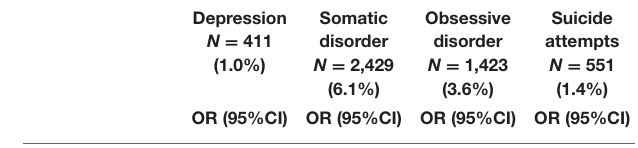
TABLE 2 | Independent associations between childhood maltreatment/disadvantage or family problems and stress scores on adaptation during first year of undergraduate life ( N = 39,573).